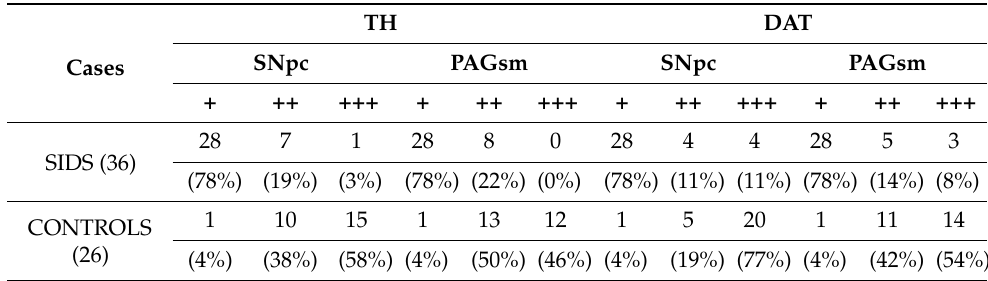
Table 2. Comparison of TH and DAT Immunoreactivity in the midbrain of SIDS and Controls.